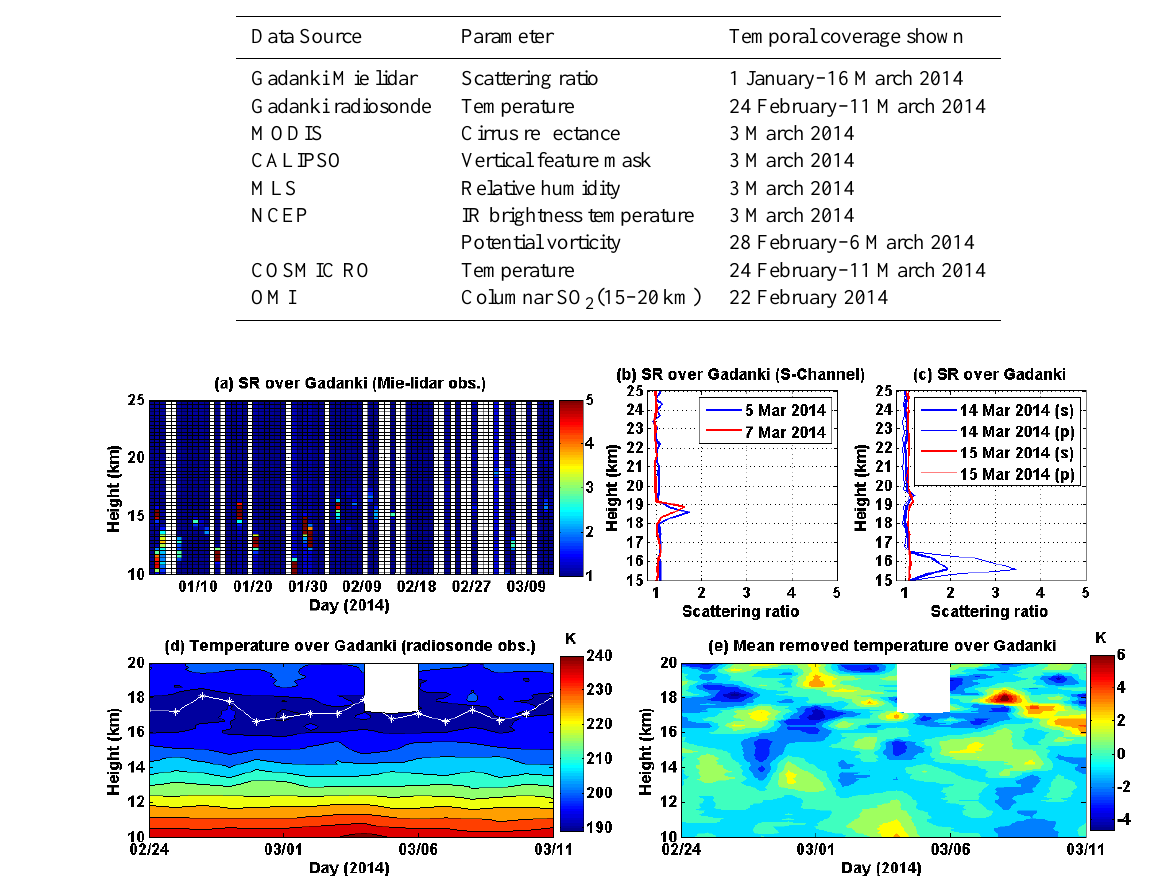
Figure 1. (a) Time–height cross section of scattering ratio from 1 January to 16 March 2014, (b) height variation of scattering ratio on 5 and 7 March 2014 from cross-polarized (S) channel, (c) height variation of scattering ratio for 14–15 March 2014 from the co- (P) and cross-polarized (S) channels obtained from Mie lidar observations over Gadanki and (d, e) height variations of (d) daily temperature and (e) mean removed daily temperature for 24 February–11 March 2014 obtained from radiosonde observations at Gadanki. The daily cold point tropopause variation is plotted with white stars ( ∗ ) in (d)